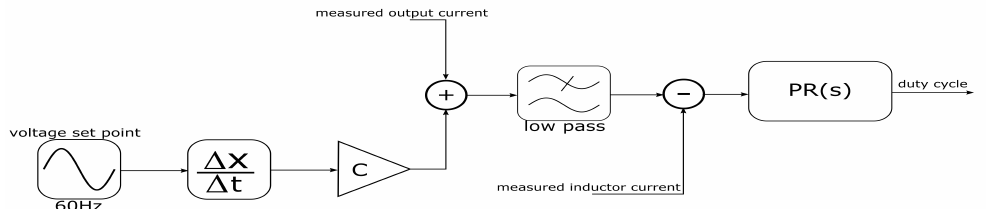
Figure 6. Voltage control loop implemented at the VSI [31].